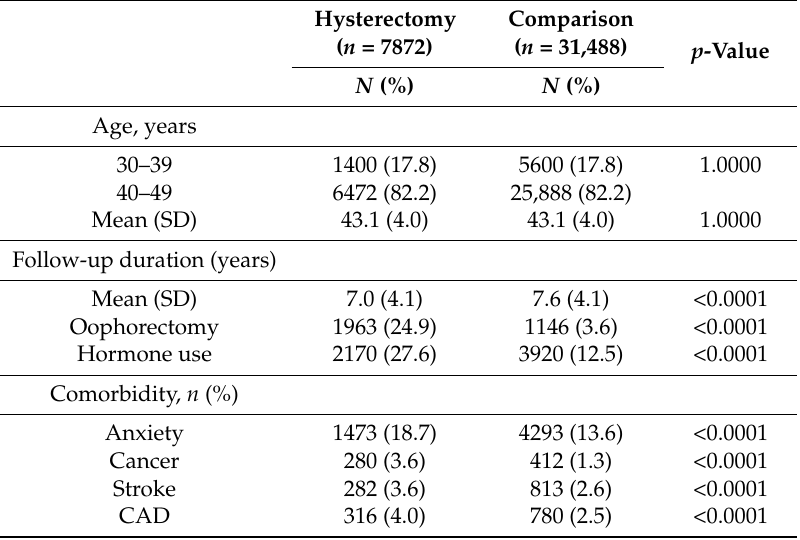
Table 1. Baseline characteristics in women with and without hysterectomy. Hysterectomy ( n =